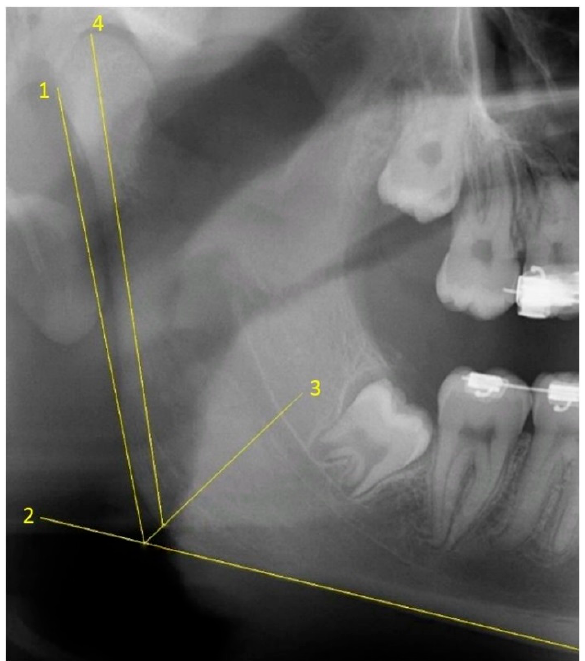
Figure 1. Ramus height measurement on the right side of the panorex using the bisection method. Lines 1 and 2 are the tangents of the mandibular ramus and the body, respectively. Line 3 is the bisection line dividing the angle between the two tangents in half. Line 4 is used to measure the ramus height and goes from the gonial angle (where line 3 crosses the curvature of the angle of the mandible, i.e., point gonion) to the highest point on the top of the condyle, i.e., point condyle.